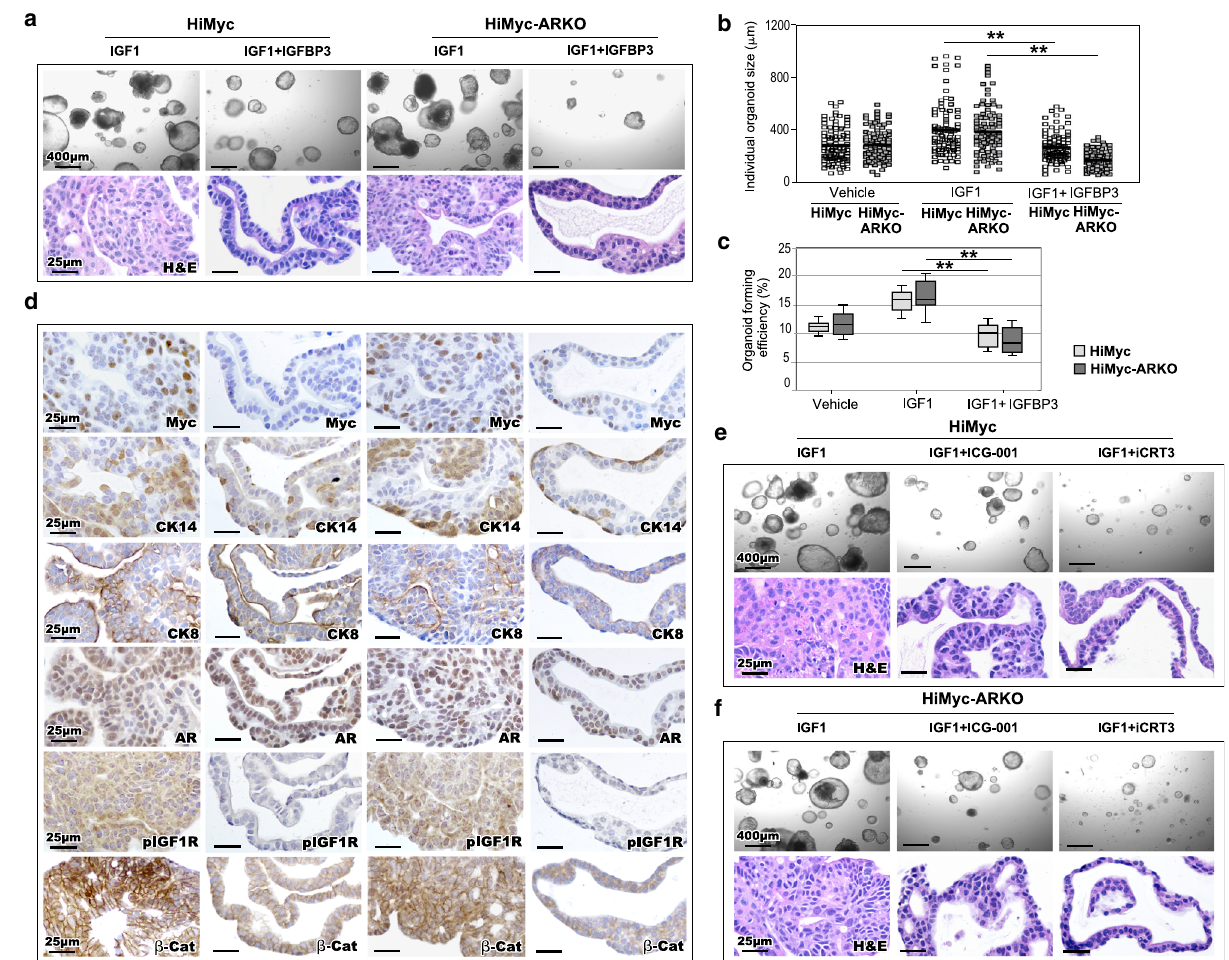
Fig. 6 | Identifying the reciprocal effect of stromal AR action on prostatic epithelial organoid oncogenic transformation and growth. a Organoid culture of prostatic epithelial cells from 12-week-old Hi-Myc:R26 mTmG/+ :Gli1 CreER/+ and Hi- Myc:R26 mTmG/+ :Ar L/Y :Gli1 CreER/+ mice,followingtreatmentwithvehicle,IGF1(100ng/ml), orIGF1(100ng/ml)+IGFBP3(1 μ g/ml).Representativeof bright fi eld imagesand HE noids ( n =100) per group examined over three independent experiments. The centerline representsthe medianvalue in each group. c Quanti fi cationof organoid forming ef fi ciencyshowing the percentage of organoids above 50 μ m diameter per totalcellsseededatday0inawell.Thecenterlinerepresentsthemedianvalue,the box borders represent the lower and upper quartiles (25% and 75% percentiles,